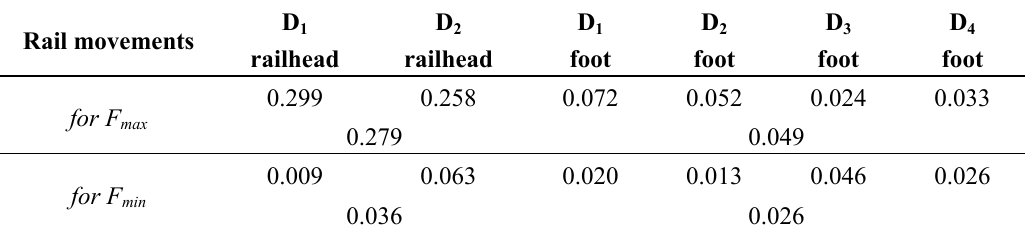
Table 3. Variation of rail movements due to fatigue process.